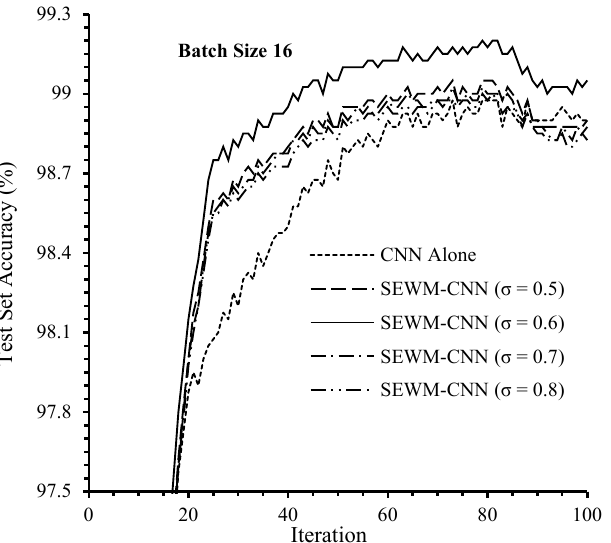
Figure 5. Performance of CNN and proposed SEWM-CNN varying iteration on ISI Bengali dataset.